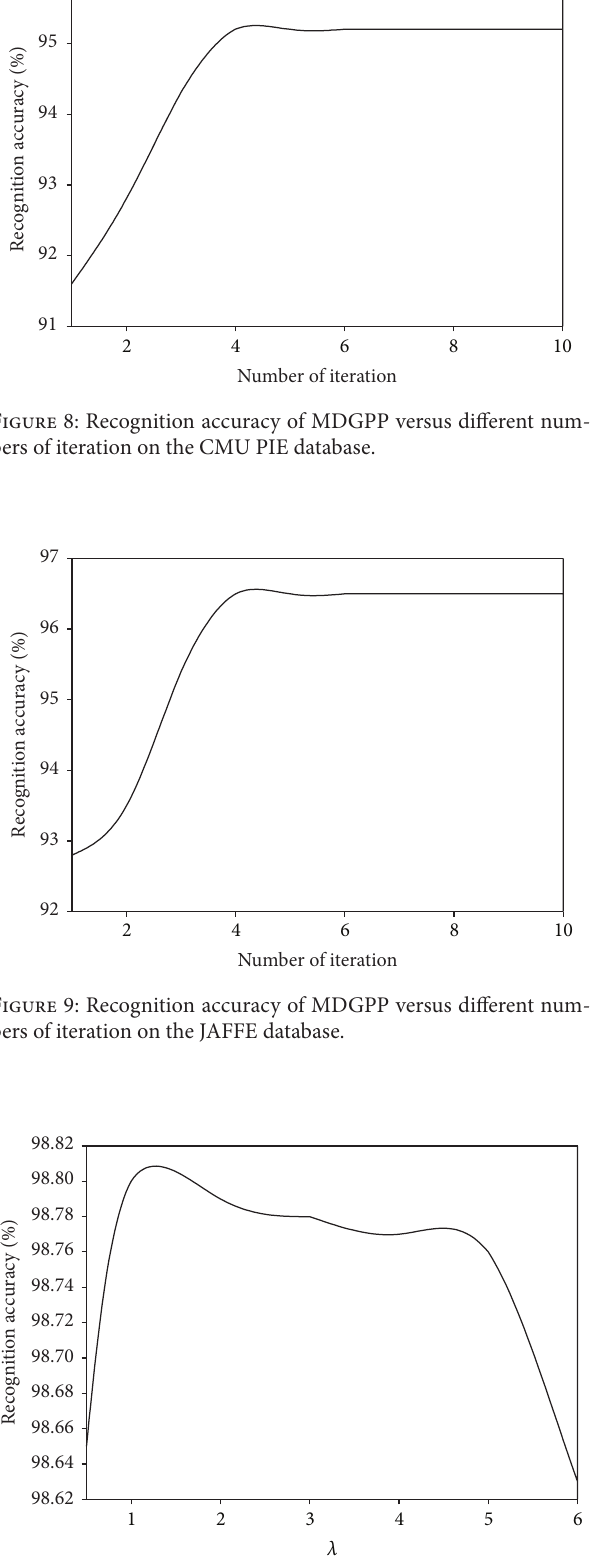
Figure 10: Recognition accuracy of MDGPP versus varying param- eter 𝜆 on the AR database.